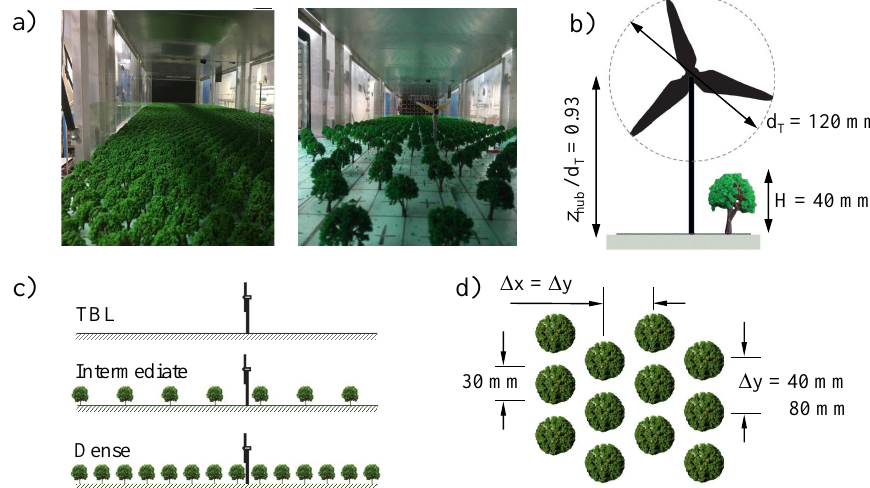
Figure 1. ( a ) Photographs of the wind tunnel with the intermediate and dense tree canopy models; ( b ) basic dimensions of the model wind turbine and tree; ( c ) side view of the scenarios; ( d ) top view of the geometrical layout of the tree